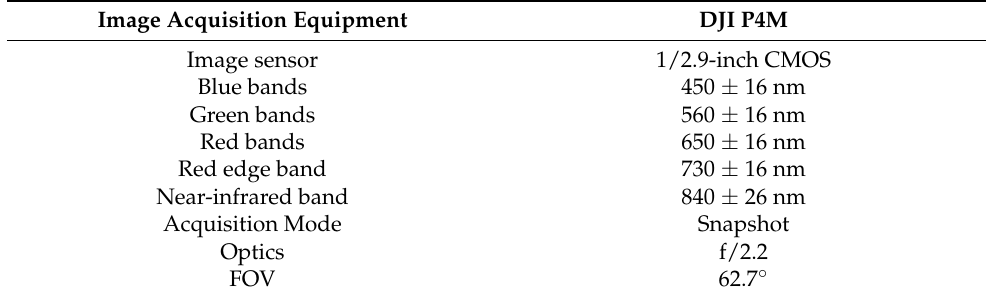
Table 1. Drone equipment parameters.